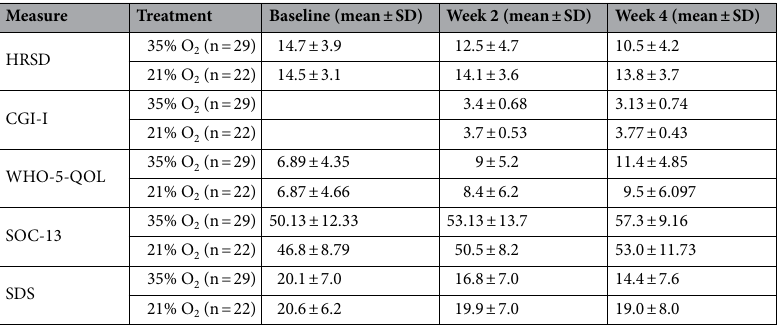
Table 2. Effect of oxygen treatment on study outcomes. CGI-I clinical global impression-improvement, CI confidence interval, HRSD Hamilton rating scale for depression, SD standard deviation, SDS Sheehan disability scale, SOC sense of coherence, WHO-5-QOL world health organization-5 quality of life (questionnaire).